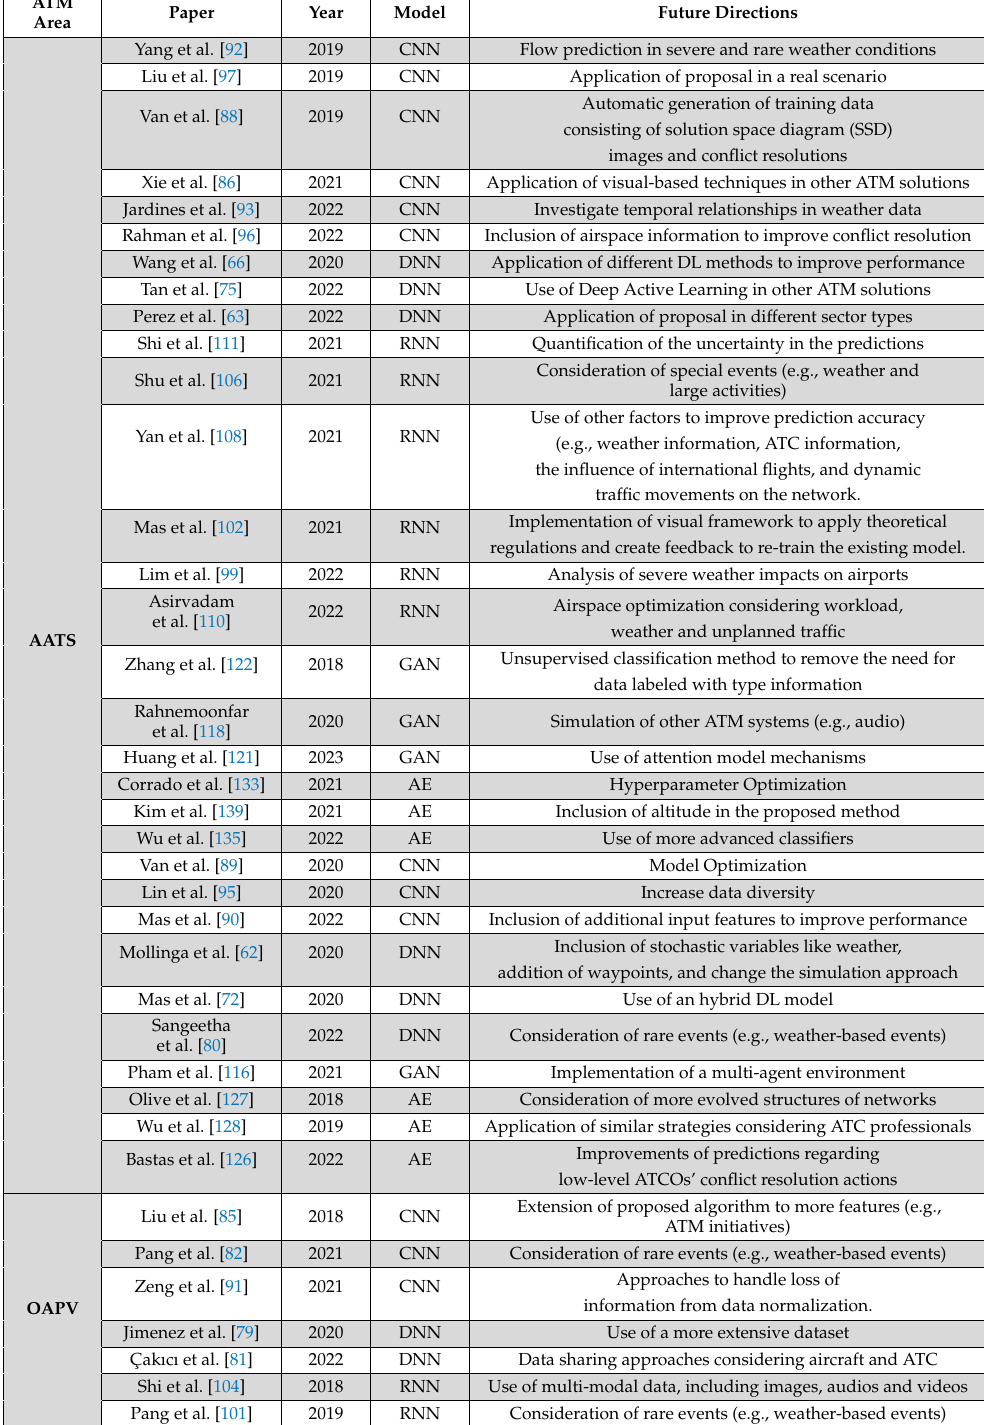
Table 2. Future directions for different ATM